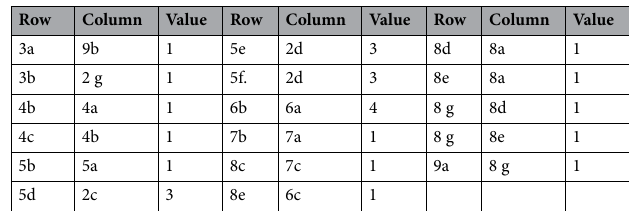
Table 5. Deviation gradient matrix